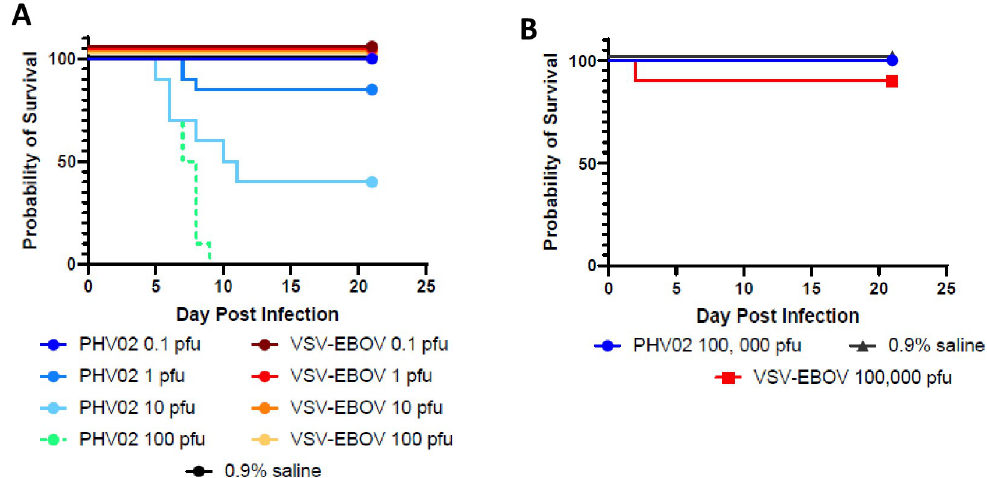
Fig 4. Survival distribution of infant and adult Swiss-Webster mice inoculated IC with rVSV-Nipah or rVSV-EBOV. A. 8-day-old mice (10 animals/group) inoculated IC with 0.1, 1, 10 or 100 pfu of PHV02 (VSV-Nipah virus), rVSV-EBOV, or 0.9% saline. rVSV-EBOV was avirulent at all dose levels. The IC LD50 for PHV02 is 5.3 pfu, and the LD50 of rVSV-EBOV is > 100 pfu. B. 6- to 8-week-old Swiss-Webster mice (10 animals/group) inoculated IC with 100,000 pfu of VSV-Nipah virus, rVSV-EBOV, or 0.9% saline.